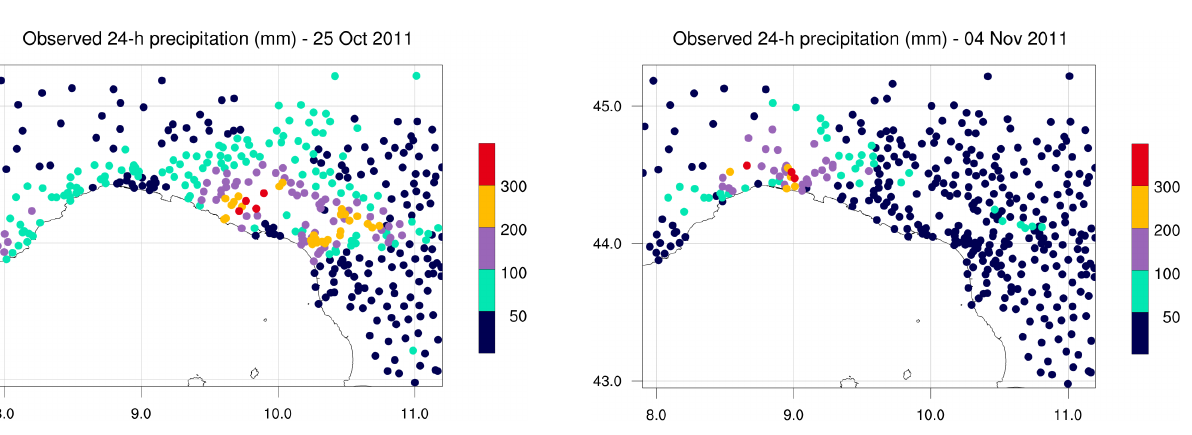
Figure 2. Observed precipitation accumulated in the 24h period starting at 00:00UTC of 25 October 2011. Parallels and meridians are drawn every 1 ◦ .